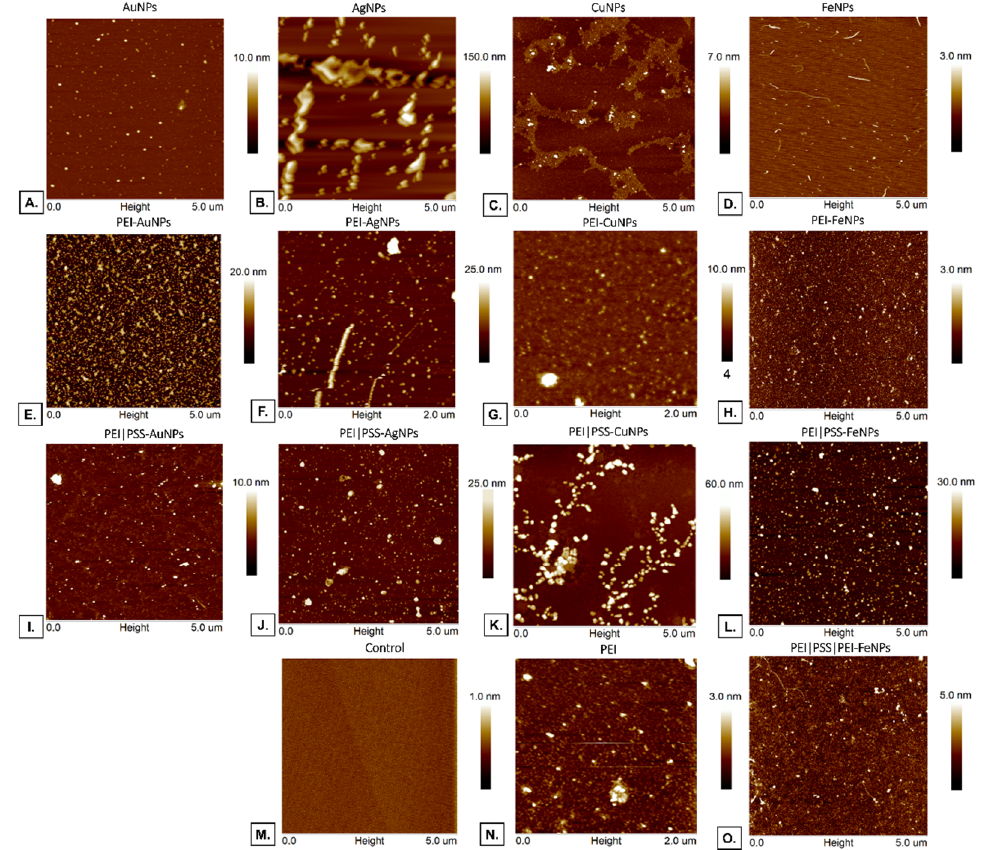
Figure 10. AFM image of polyelectrolyte membranes with incorporated nanoparticles deposited on the gold mica substrate cover. Key to the symbols: PEI-AuNPs: the membrane build of the polyethylenimine with AuNPs incorporated, PEI-AgNPs: the membrane build of the polyethylenimine with AgNPs incorporated, PEI-CuNPs: the membrane build of the polyethylenimine with CuNPs incorporated, PEI-FeNPs: the membrane build of the polyethylenimine with FeNPs incorporated; PEI|PSS-AuNPs: the membrane layer build of the polystyrene sulfonate with AuNPs incorporated deposited on polyethylenimine, PEI|PSS-AgNPs: the membrane build of the polystyrene sulfonate with AgNPs incorporated deposited on polyethylenimine, PEI|PSS-CuNPs: the membrane build of the polystyrene sulfonate with CuNPs incorporated deposited on polyethylenimine, PEI|PSS- FeNPs: the membrane build of the polystyrene sulfonate with FeNPs incorporated deposited on polyethylenimine, PEI: the polyethylenimine membrane, Control: mica surface.